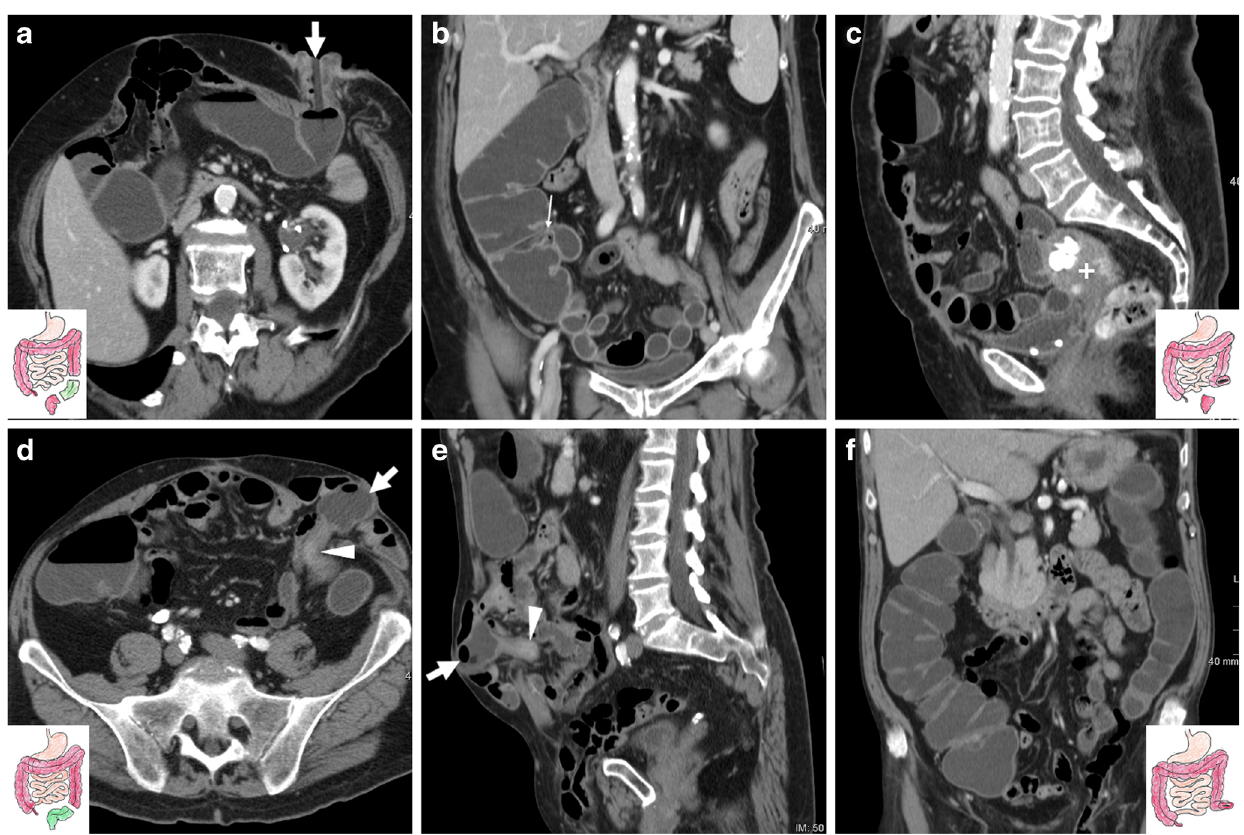
Fig. 1 Two examples of water-enema multidetector CT (WE-MDCT) via the colostomy (surgical schemes shown in insets). a – c performed before elective bowel recanalisation in a 79-year-old female with previous Hartmann ’ s resection of the sigmoid and descending colon for complicated diverticulitis. Optimal retrograde distension of the residual large bowel up to the ileocecal valve (thin arrow in b ) is achieved using a Foley catheter (thick arrow in a ) positioned in the left-sided stoma. Note